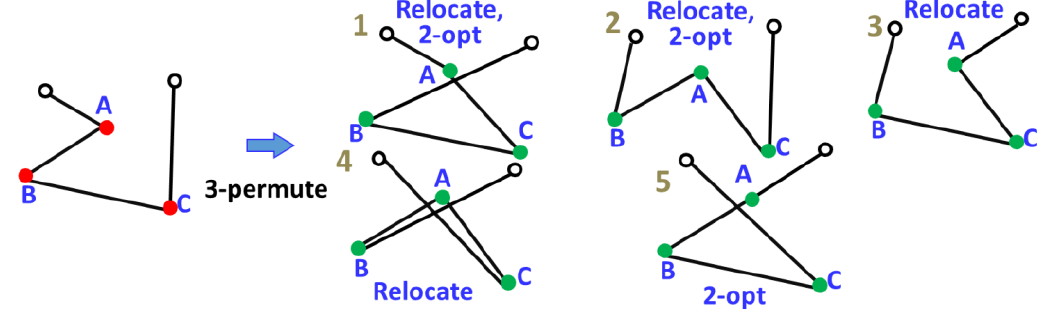
Figure 10. Six neighboring solutions created by 3–permute, but none of them is unique.